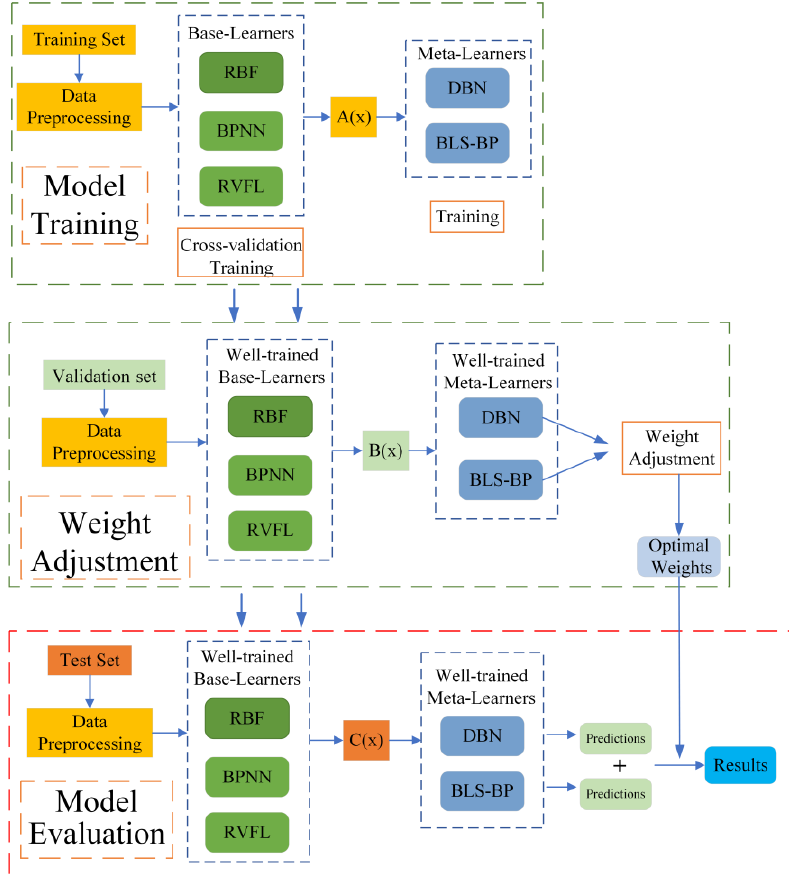
Figure 4. Algorithm structure.